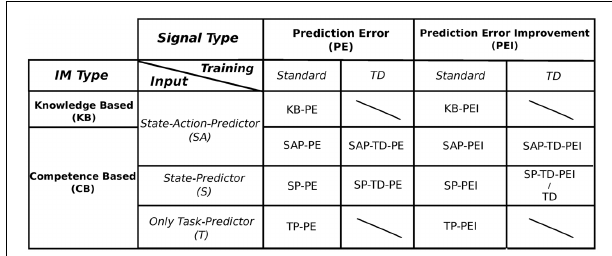
FIGURE 3 | Scheme of the different experimental conditions, divided by typology of signal, typology of intrinsic motivations, input, and training algorithm. Note that the random (RND) condition is not mentioned in this table because it does not use any reinforcement signal to determine the selection of the experts. See Section 2.3.1 and 2.3.2 for a detailed description of all the different